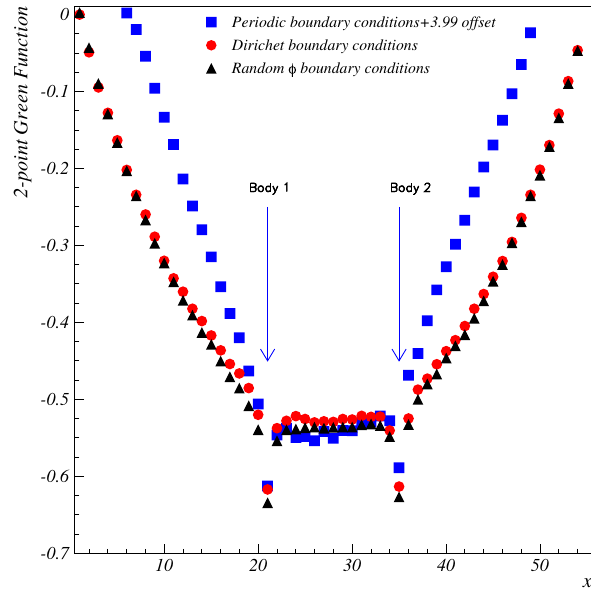
Fig. 9 Independence of the simulation on the choice of boundary con- ditions.Theresultsareobtainedwhenkeepingonly ∂φ∂φ andthematter terms in the Lagrangian (1 / x free massless field case). The potential G 2 p is plotted as a function of distance. The simulations were run for a lattice size N = 55, a coupling value g = 10 − 2 , a correlation coeffi- cient (see Sect. B.1) N cor = 20 and for N s = 3 . 5 × 10 4 configurations. Two sources are located on the x -axis at d = ± 7 from the lattice center at x center = 28. The circles are for Dirichlet boundary conditions. The sq u ares are obtained with periodic boundary conditions. The triangles are for random field boundary conditions. Except near the boundaries and except for a constant offset of 0.0145 added to the result obtained with the Dirichlet conditions (irrelevant since G 2 p is the potential), all results agree and display the expected 1 / x potential for each sources ( contin u o u s c u rve )